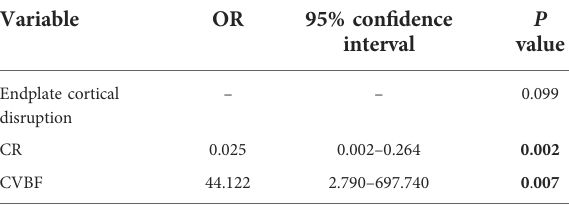
TABLE 4 Multivariate logistic analysis for intradiscal